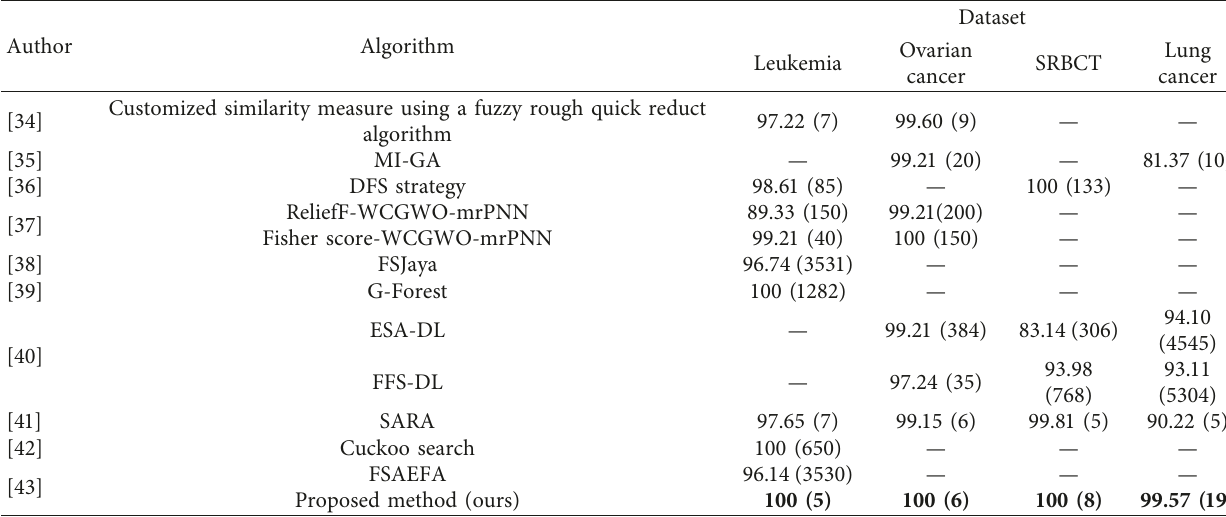
Table 10: Comparison of proposed method with some existing research: with reduced features shown inside the parentheses. The symbol “—” indicates that no information is available. The best results are shown in bold